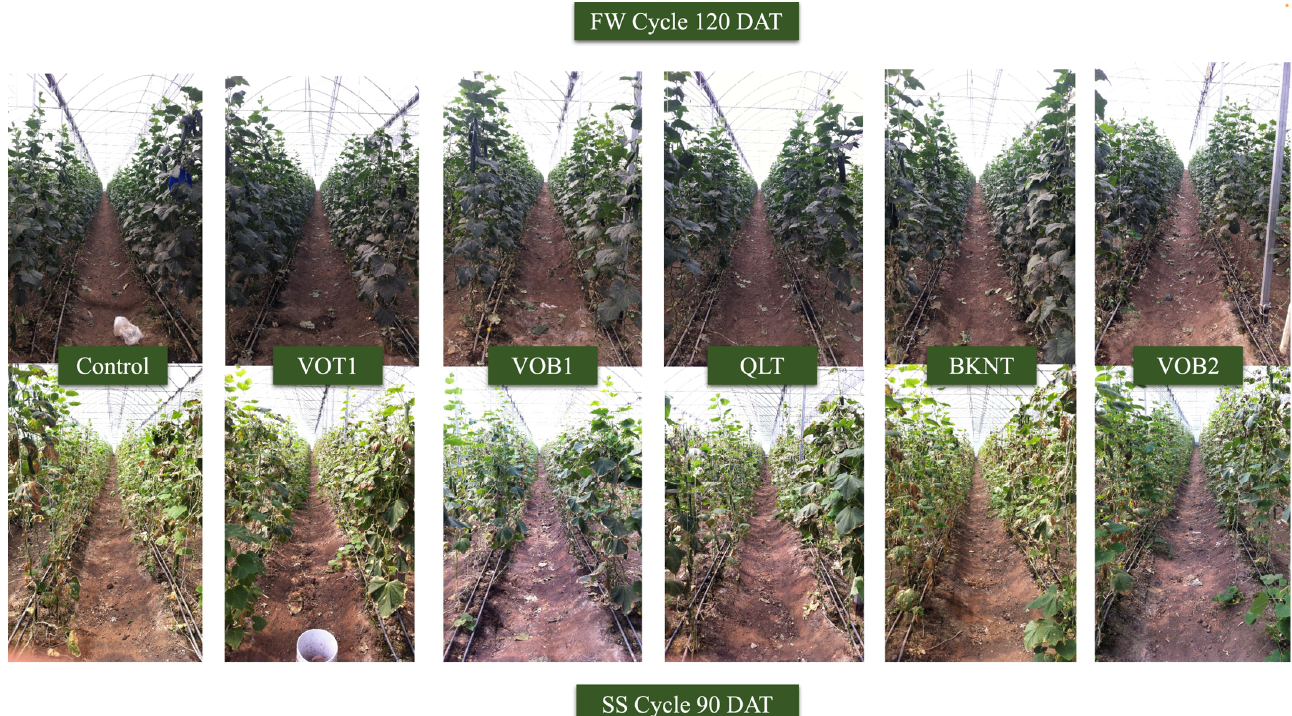
Figure 2. Greenhouse view of each treatment at the end of the fall–winter 2015–16 and spring–summer 2016 production cycles. The treatments were control: Serenade Max ® 14.6; Apolo ® ; hydrogen peroxide); VOT1: Trichoderma harzianum strain VOT1; QLT: T. harzianum strain QLT; BKNT: T. harzianum strain BKNT; VOB1: Bacillus subtilis strain VOB1; VOB2; B. subtilis strain VOB2. According to the severity scale developed for downy mildew of cucurbits [21], the VOB1 strain of B. subtilis presents the best control of the disease. Similar data were obtained for the VOB2 of B. subtilis for the FW and SS